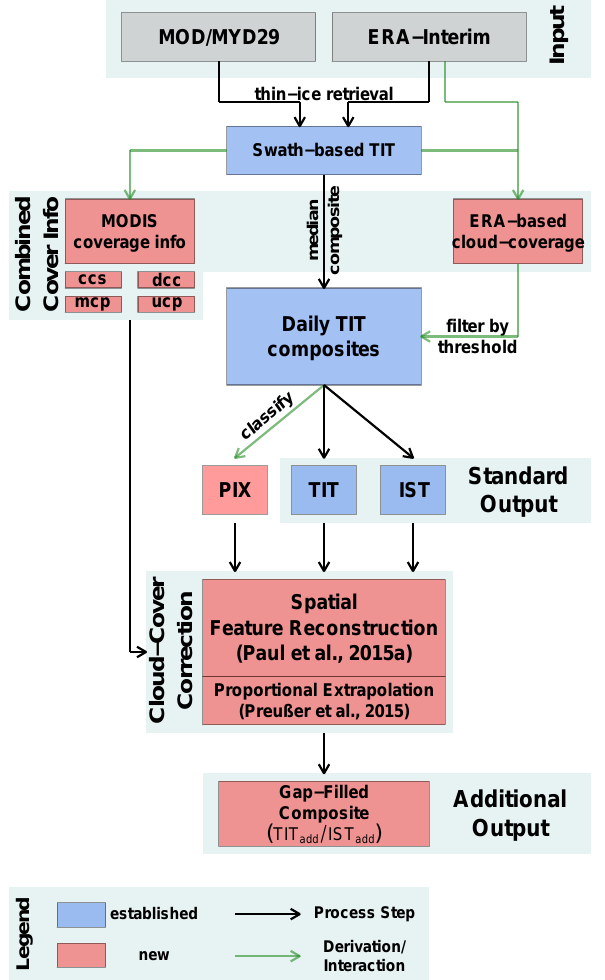
Figure 2. Work flow based on the described input data and thin- ice retrieval. Established processing steps that were already used in other studies are marked in blue, while new additions are marked in red. These additions comprise a persistence index (PIX), the newly defined combined cloud-cover information of MODIS cloud mask and ERA-Interim medium-level cloud cover. Missing data due to cloud cover are accounted for by a two-step procedure that com- prises spatial feature reconstruction (Paul et al., 2015a) and pro- portional extrapolation (Preußer et al., 2015). The combined cloud- cover information separates between confident clear-sky (ccs), defi- nite cloud-cover (dcc), mixed-covered pixels (mcp), and uncovered pixels